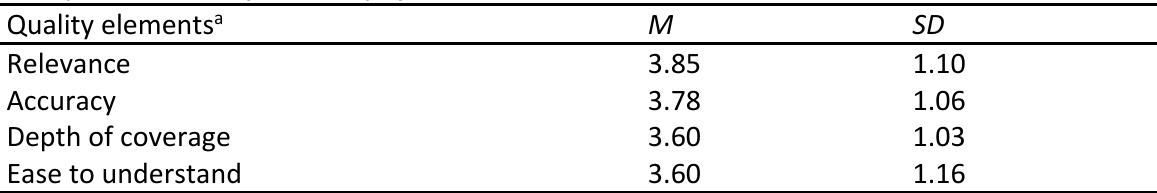
Descriptive Statistics for Quality of CSA Advise (n =